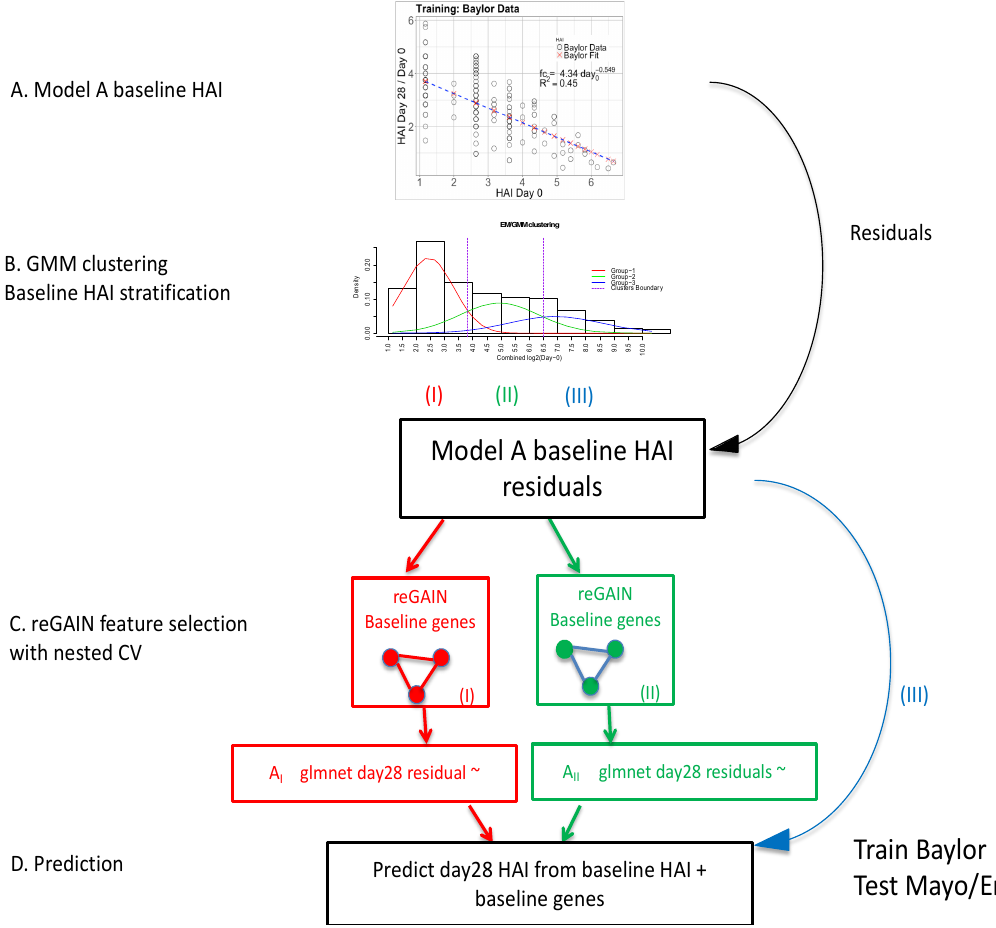
Figure 1. A diagram of the overall modeling approach in four parts. ( A ) Inverse power model is used to model the pre − existing hemagglutination inhibition (HAI) antibody titer (day-0 HAI). The horizontal axis is the day-0 HAI, and the vertical axis is the ratio of day-28/day-0 (fold-change) according to the inverse power model. ( B ) Day-0 HAI in all data sets are combined and clustered into three groups (low (red I), medium (green II), and high (blue III)) using Gaussian mixture modeling (GMM) clustering. ( C ) The regression-based genetic association interaction network (reGAIN) method is used to compute the weighted matrix for gene pairs through 10-outer/10-inner nested cross-validation (CV), and top 200 interacting genes with highest reGAIN values are selected as predictor variables in two of the baseline groups (low/red and medium/green). We excluded the third group (high day-0, blue) since the power law model works well in that group. ( D ) Final gene modeling using glmnet penalized regression, where the dependent variable is the residual from A, and predictor variables are the top 200 gene ratios from C. In gene modeling, we again trained on the Baylor data and tested on Emory and Mayo data for each group, separately.